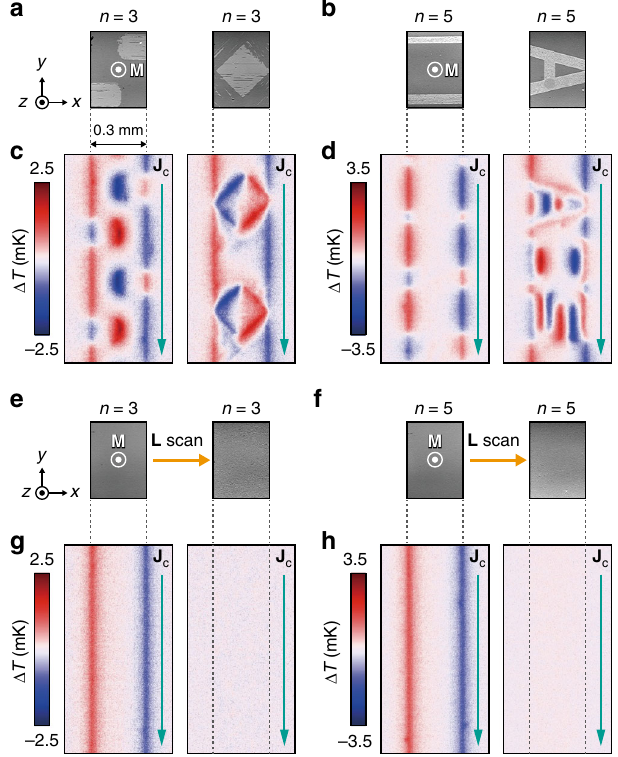
Fig. 4 Flexible design and on/off control of temperature modulation. a , b Magneto-optical images for the [Co/Pt] 3 ( a ) and [Co/Pt] 5 ( b ) strips with pre-designed magnetic domain patterns. The left image in a shows the magnetic domains with periodical rounded rectangles that start from the edges and terminate at the middle of the strip, while the right image shows diamond-shaped patterns. The left image in b shows line patterns with different widths, while the right image shows the alphabet patterns AOS, where only the character A is presented in the viewing area of the microscope. All the domain patterns were prepared by means of the AO- HDS. c , d Corresponding Δ T images for the [Co/Pt] 3 ( c ) and [Co/Pt] 5 ( d ) strips. The difference in the magnitude of the Δ T signals between the [Co/Pt] 3 and [Co/Pt] 5 samples can be explained by the thickness dependence of the AEE-induced temperature modulation 9 . e , f Magneto- optical images for the [Co/Pt] 3 ( e ) and [Co/Pt] 5 ( f ) strips before and after linearly polarized light ( L ) illumination. g , h Corresponding Δ T images for the [Co/Pt] 3 ( g ) and [Co/Pt] 5 ( h ) strips. The AEE-induced temperature modulation is macroscopically canceled out after L illumination due to the creation of random multiple